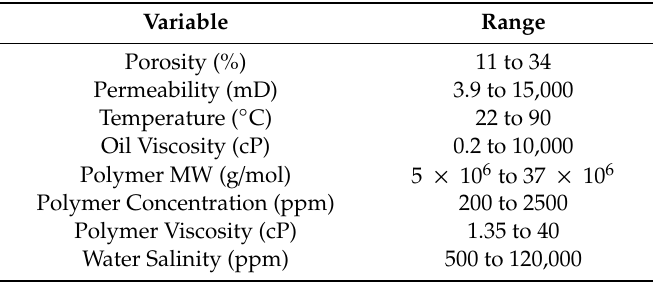
Table 4. Range of variables: polymer-flooding pilot tests (data from